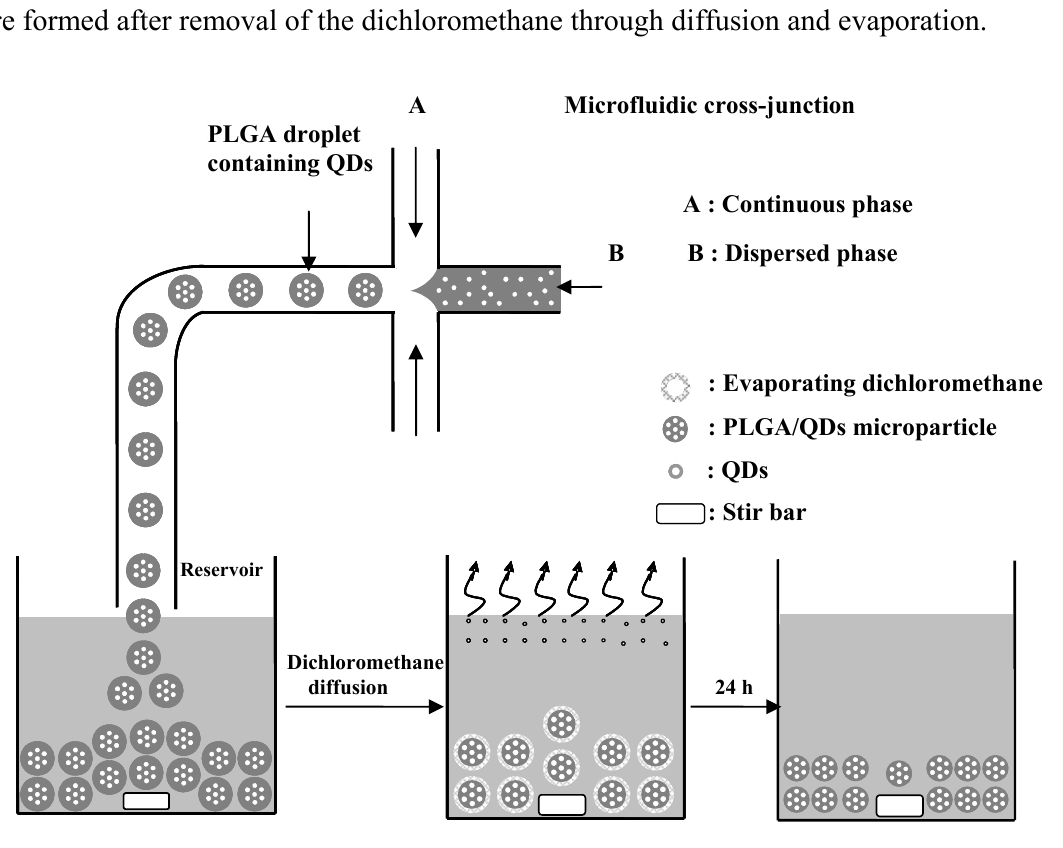
Figure 4. Schematic drawing of droplet formation in a microchannel cross-junction. Based on the principle of microfluidics for exerting control over the shear focusing force, a